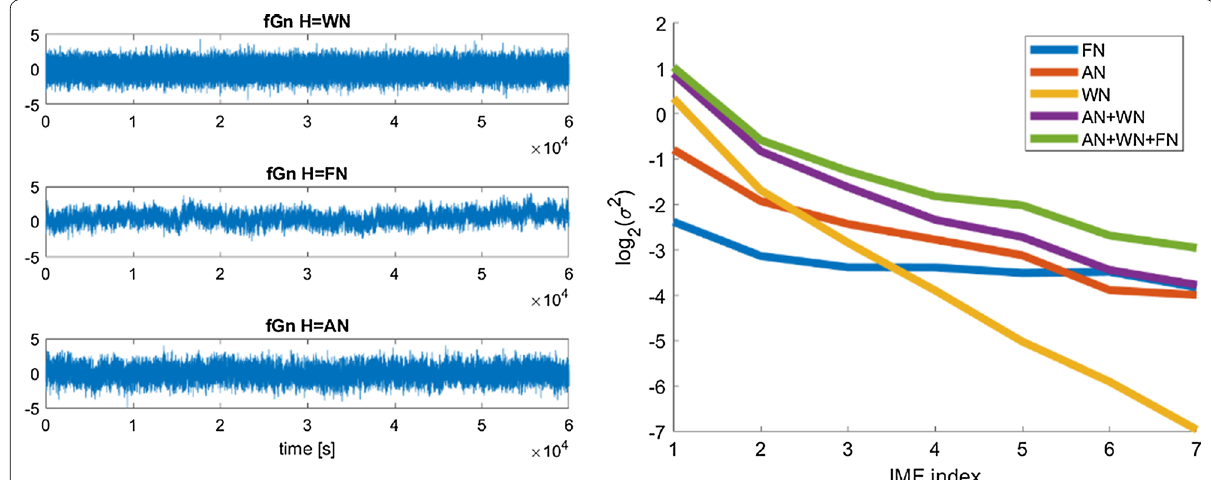
Fig. 2 Left: time series corresponding to the fGn with a different Hurst parameter (WN, FN and AN). Right: the corresponding σ 2 IMF, i , i = 1 ... 7 for different noise log 2 (cid:31) (cid:30)